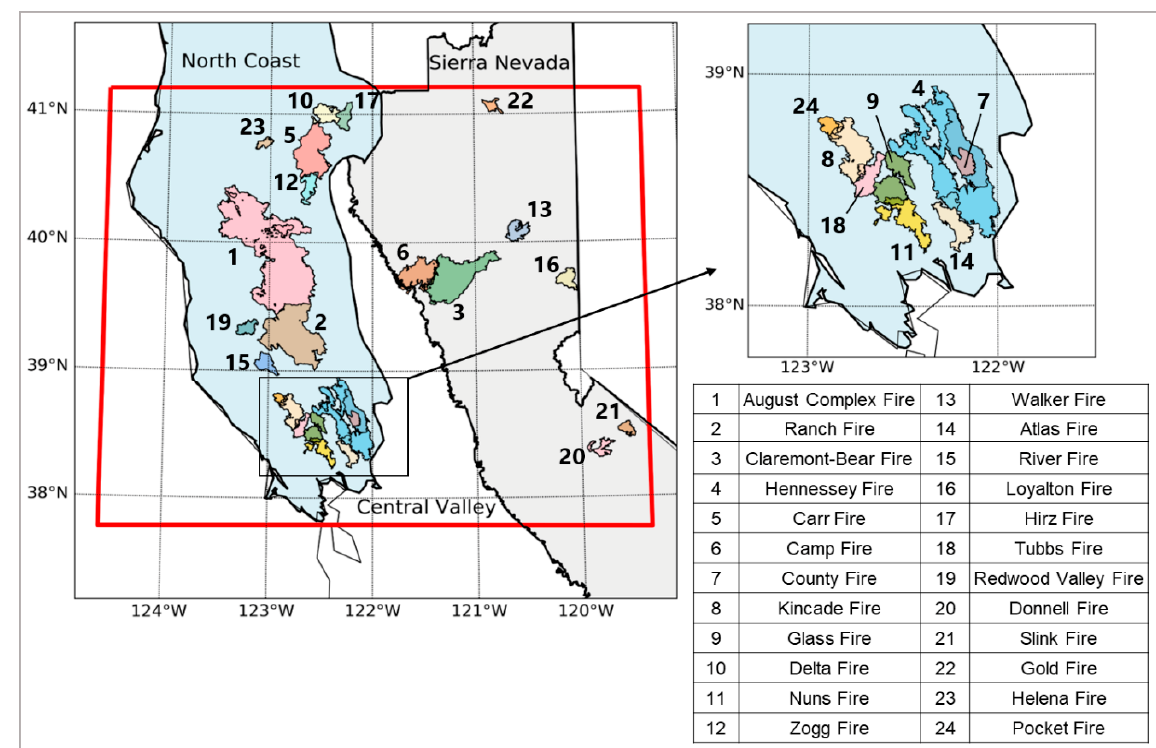
Figure 1. Study area and target wildfires. The study area is shown in a red frame. North Coast and Sierra Nevada are shown in light blue and light green, respectively. The Central Valley separates the North Coast and Sierra Nevada regions.